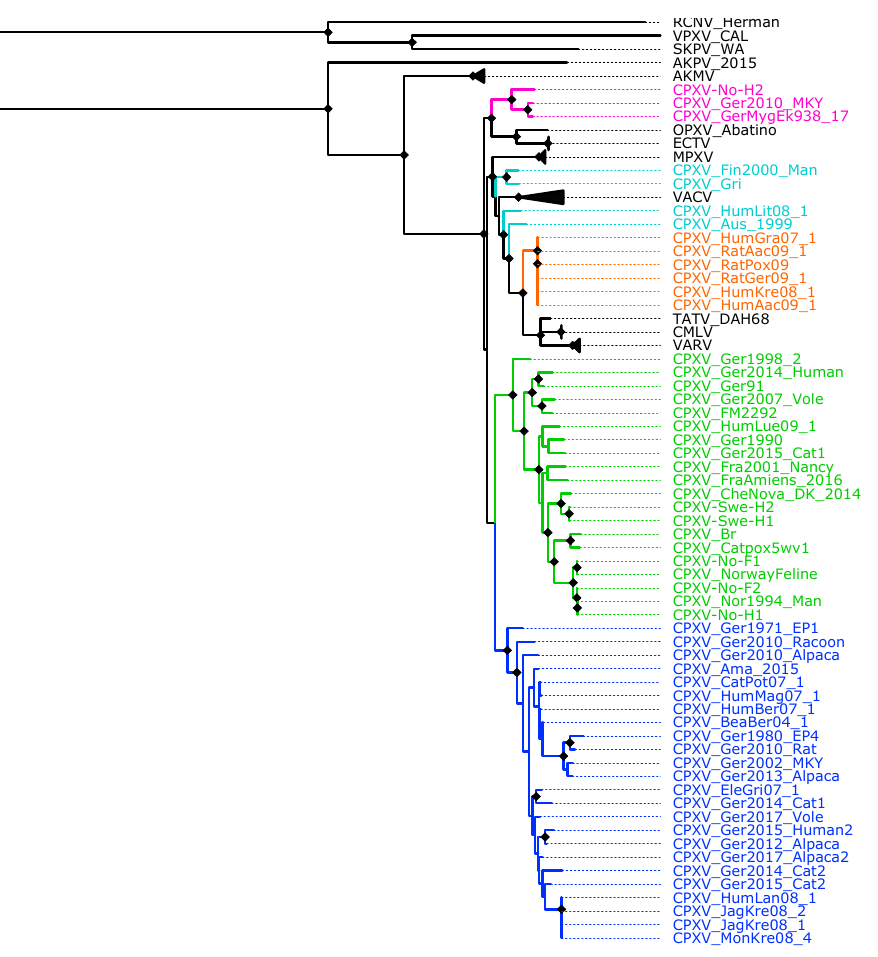
0.03 Figure 1. Maximum likelihood phylogenetic tree of 62 conserved genes from 87 orthopoxviruses. Bootstrap values were inferred from 1000 rapid bootstrap replicates. Diamonds at the nodes indicate bootstrap values > 80%. The scale indicates substitution per site. The main five cowpox virus (CPXV) clusters were highlighted in different colors: pink (Ectromelia-Abatino-like CPXV), blue (CPXV-like 1), green (CPXV-like 2), turquoise blue (Vaccinia-like CPXV) and orange (Variola-like CPXV).